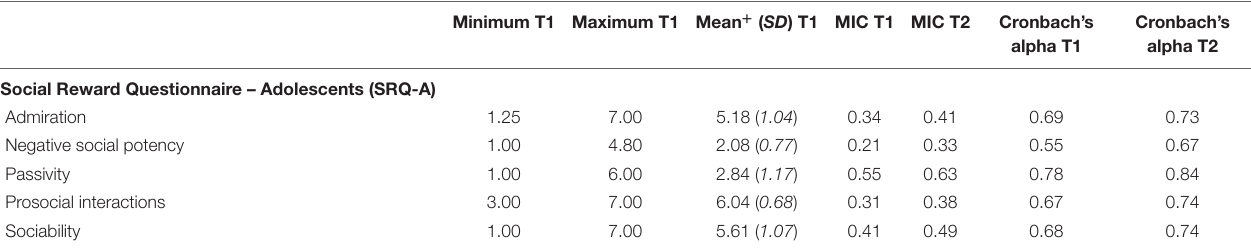
TABLE 3 | Descriptive statistics (minimum, maximum, mean, and SD), mean inter-item correlations (MICs), and Cronbach’s alphas of each subscale at T1, as well as MICs and Cronbach’s alphas at T2.